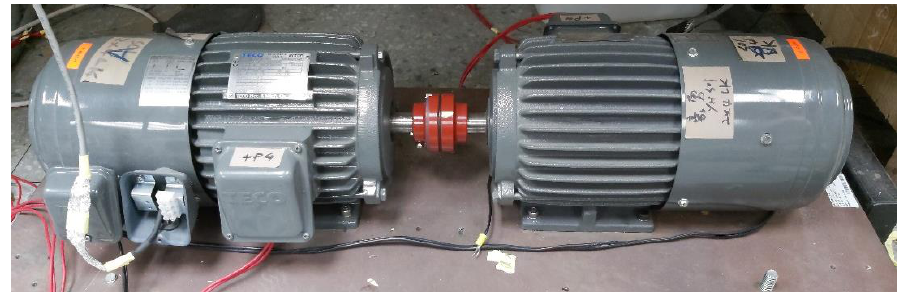
Figure 15. Photograph of the applied IMs. Simulation and experimental results are shown in every figure. The flux and torque PI controller response without correction of θ ψ condition is shown in Figure 16a. Figure 16b shows the same situation but with correction of θ ψ . s